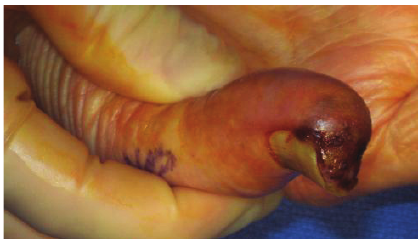
Figure 2. Subungual melanoma of the right thumb. Note pigmentary changes extending onto the pulp and exophytic nature of the